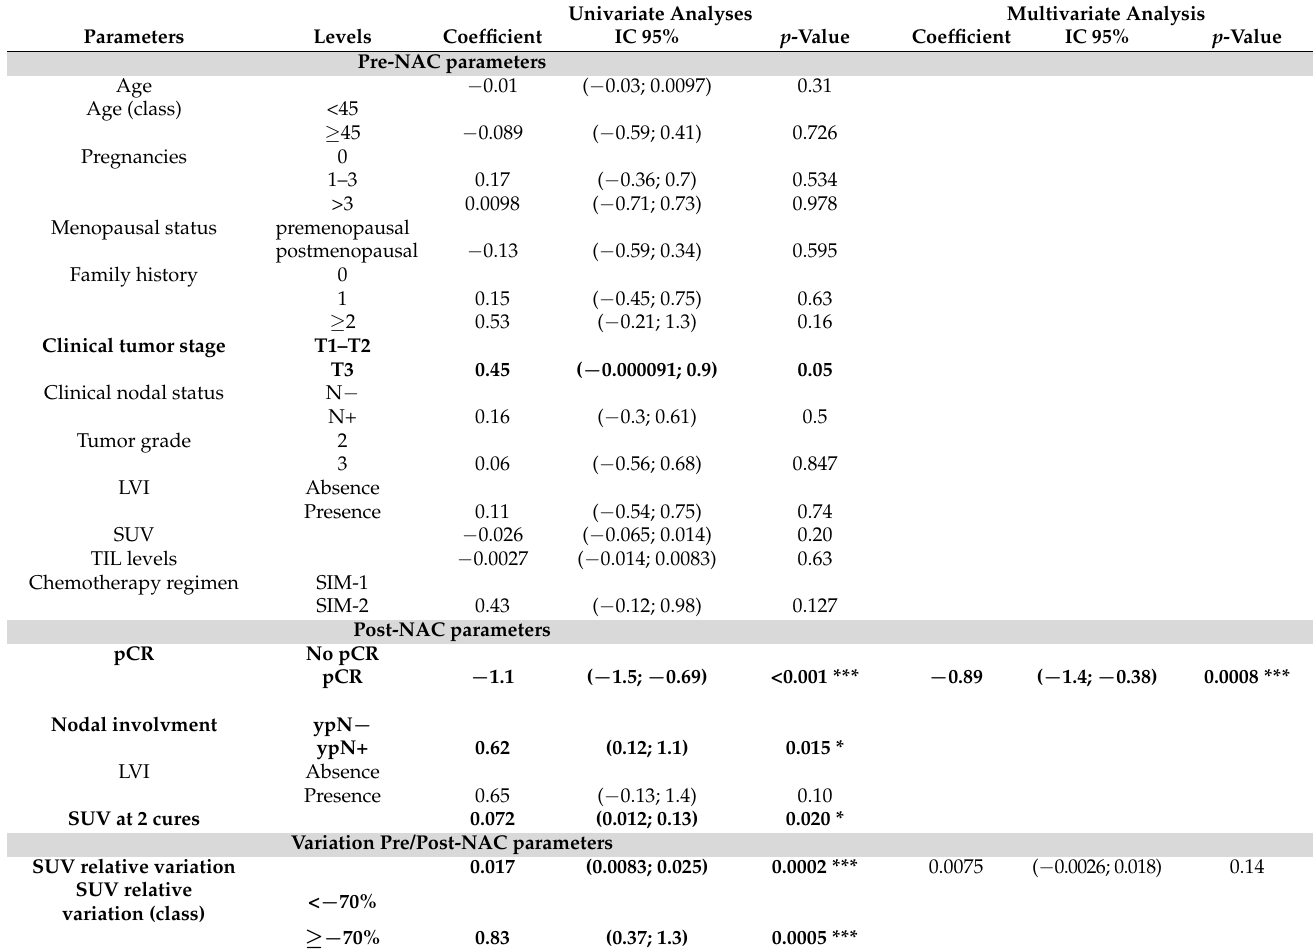
Table 2. Predictive factors associated with post-NAC TIL levels. Univariate